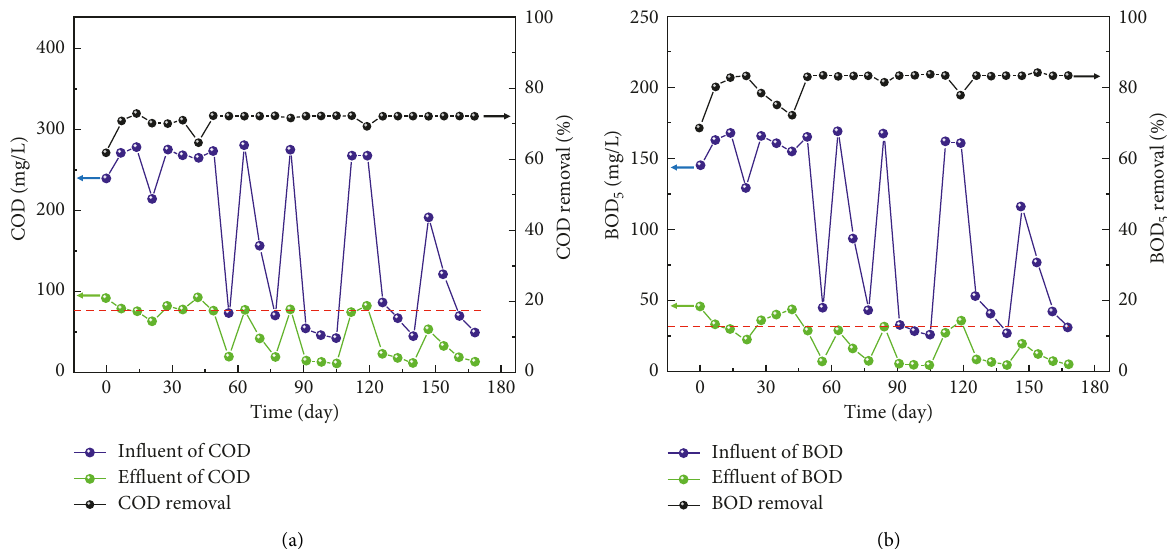
Figure 6: COD (a) and BOD 5 (b) removal during the experimental